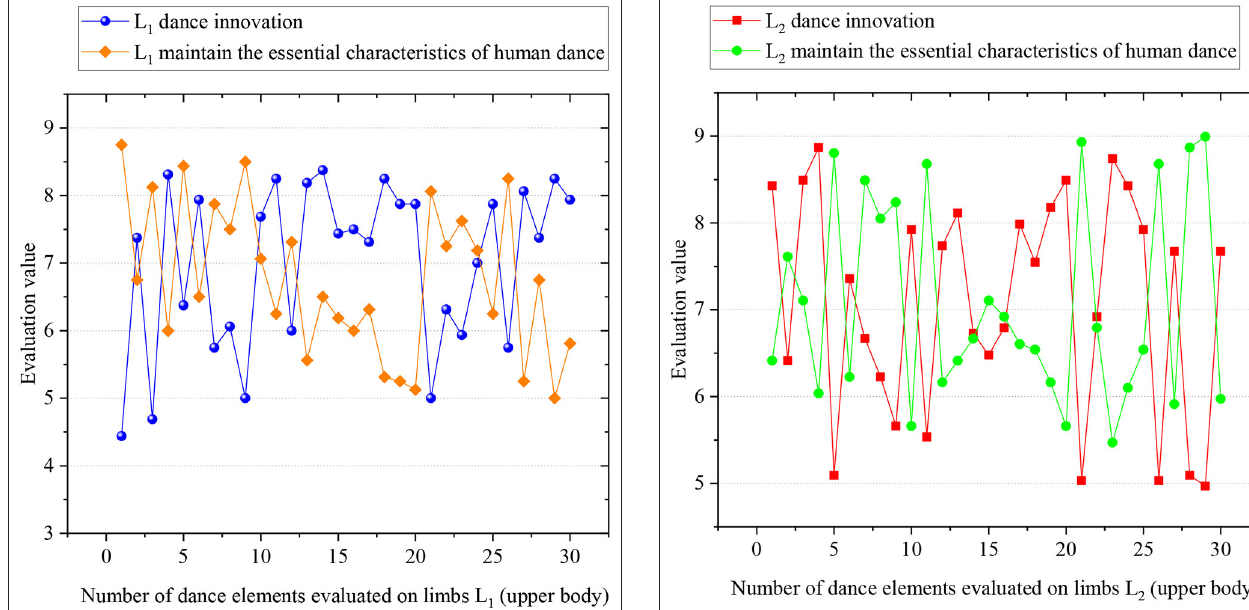
FIGURE 12 | Evaluation scores of robot-imagined 30 new dance elements on L 1 .